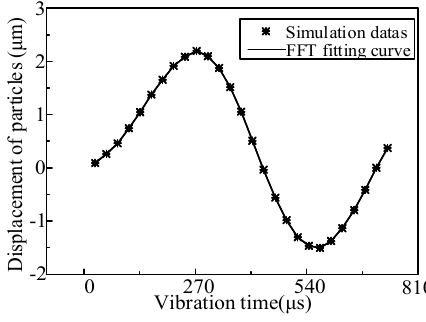
Figure 6. The fitting curve, which was determined by Equation (1).